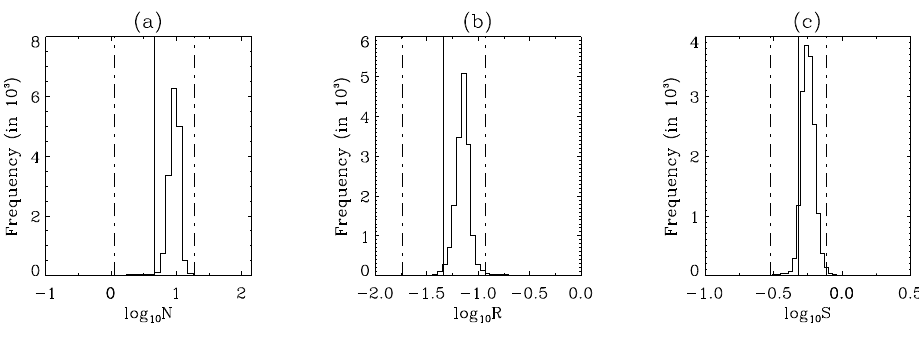
Fig. 18. Histograms of number density (a) , median radius (b) , distribution width (c) as retrieved from SAGE II measurements of aerosol extinction in September 1999. The vertical lines indicate the a priori mean state (solid), and the a priori mean state plus or minus one standard deviation (dash-dot).